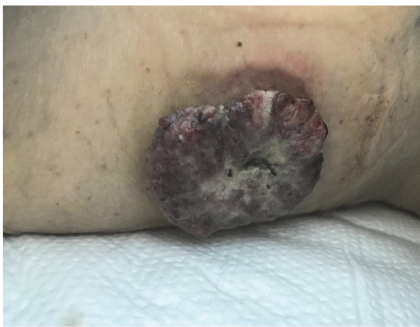
Figure 3: Ascending colon biopsy showing poorly differentiated invasive adenocarcinoma (H&E, ×